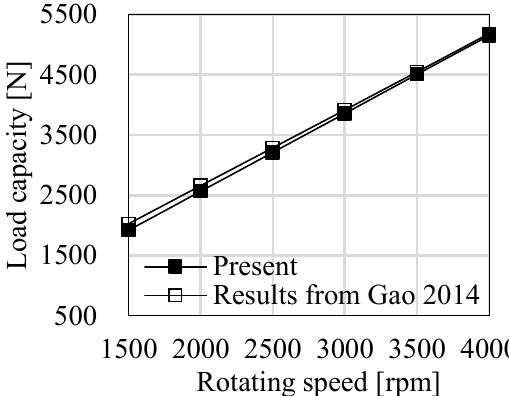
Figure 7. Comparisons of the load capacity between Fluent and the in-house solver.